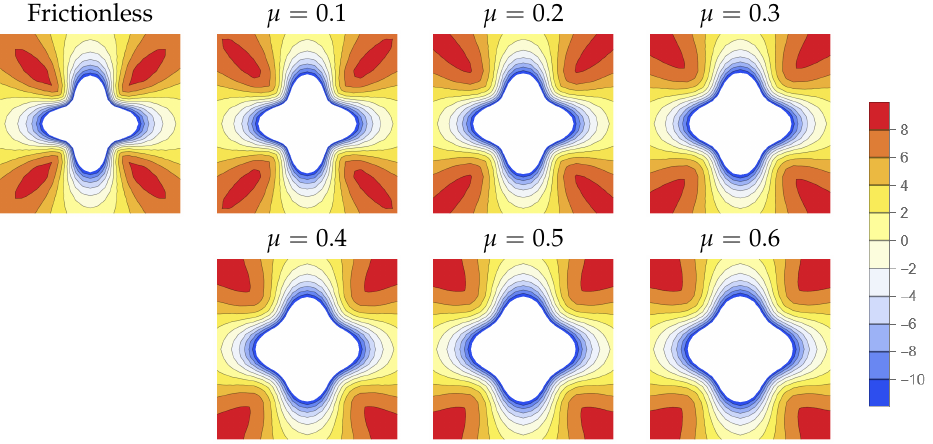
Figure 13. The sensitivity of surface topographies with varying Coulomb friction